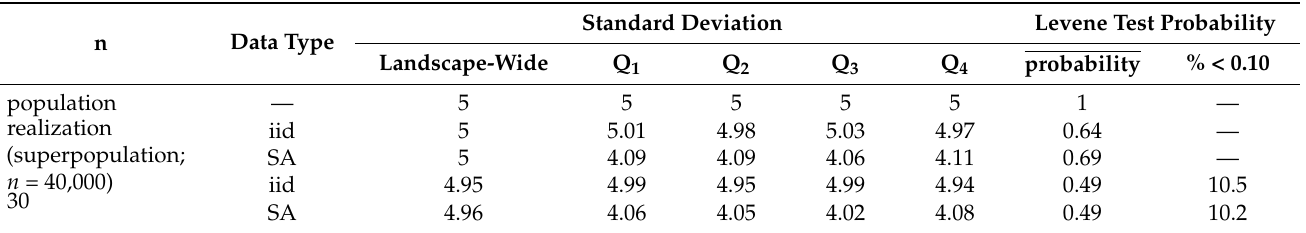
Table 5. SRS variance estimates for landscape-centered quadrant-of-the-plane subregions of a larger complete geographic landscape; 10,000